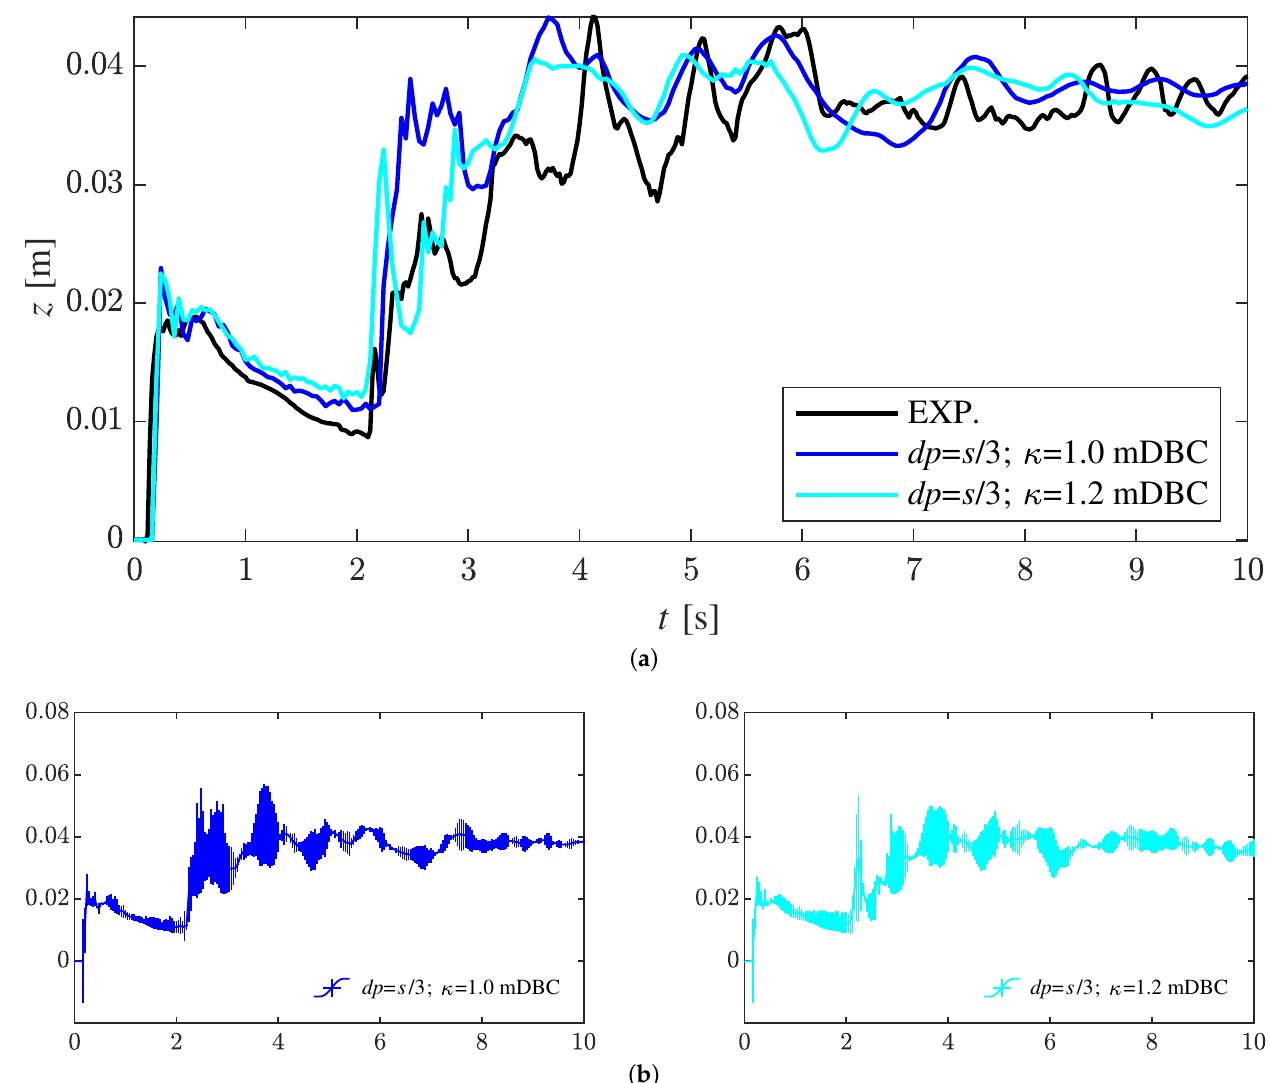
Figure 6. Comparison in P2 ( a ) and relative local elevation error ( b ) with dp = s /3 and different values of κ